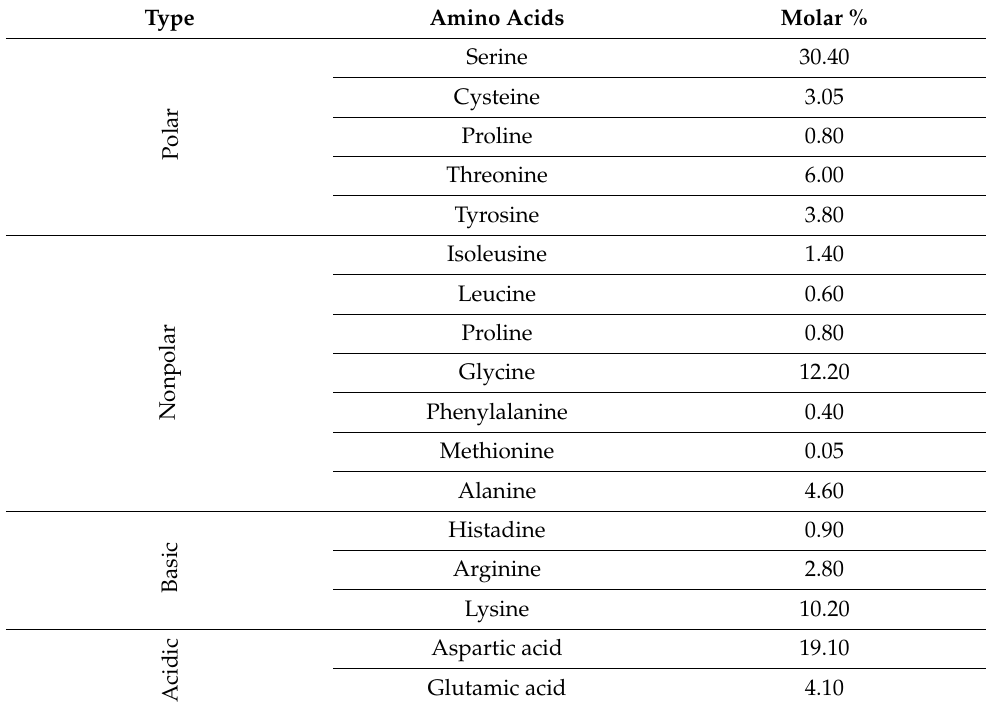
Table 2. Amino acid composition of silk sericin.